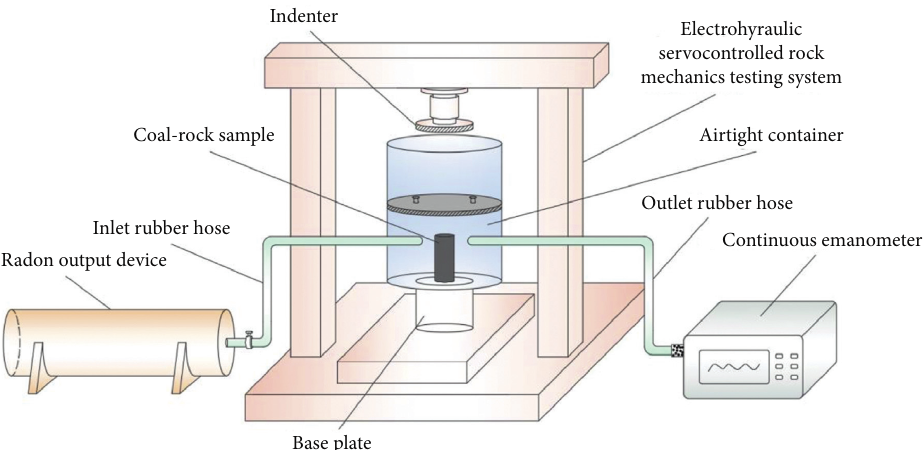
Figure 2: Schematic of the experimental apparatus.